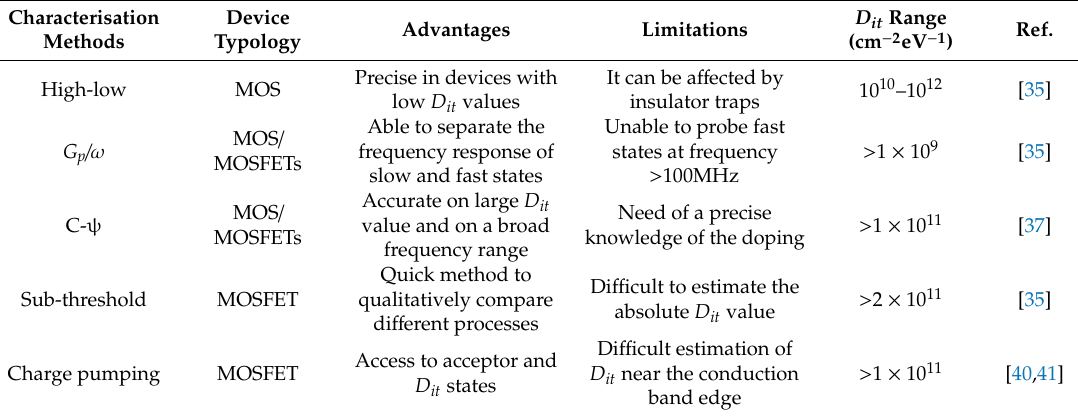
Table 2. Summary of the most widely used characterization techniques for estimating the interface state density D it .